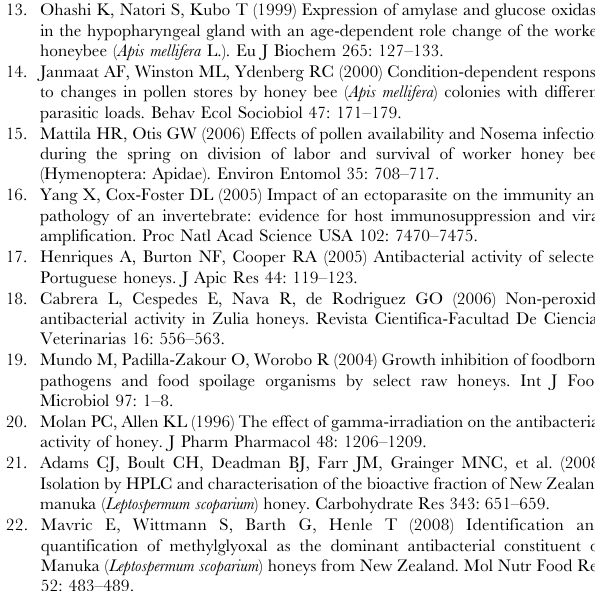
Supporting Table S2 Change in antibacterial activity of honey samples following storage at 25 u C and 4 u C (complete data